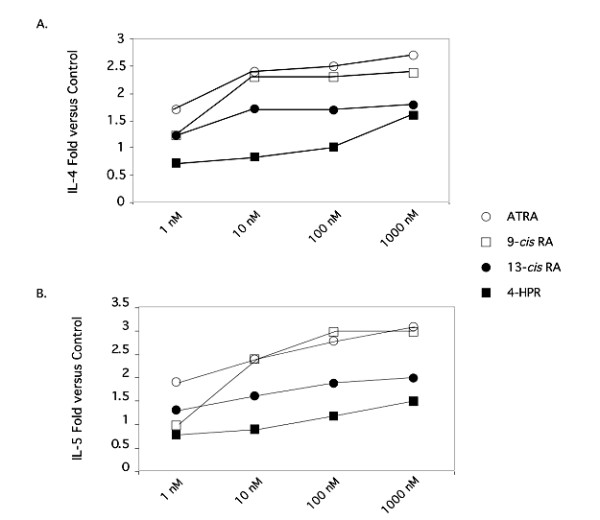
The effects of various clinically-utilized retinoid compounds on Th2-associated cytokine production by anti-CD3e-activated PBMCs. Supernatants of anti-CD3e-activated PBMCs treated with EtOH or 10-9 to 10-6 M ATRA (○), 9-cis-RA (□), 13-cis-RA (●), or 4-HPR (■) for 48 h were examined for IL-4 or IL-5. The values shown represent the average fold change obtained from 4 donors.